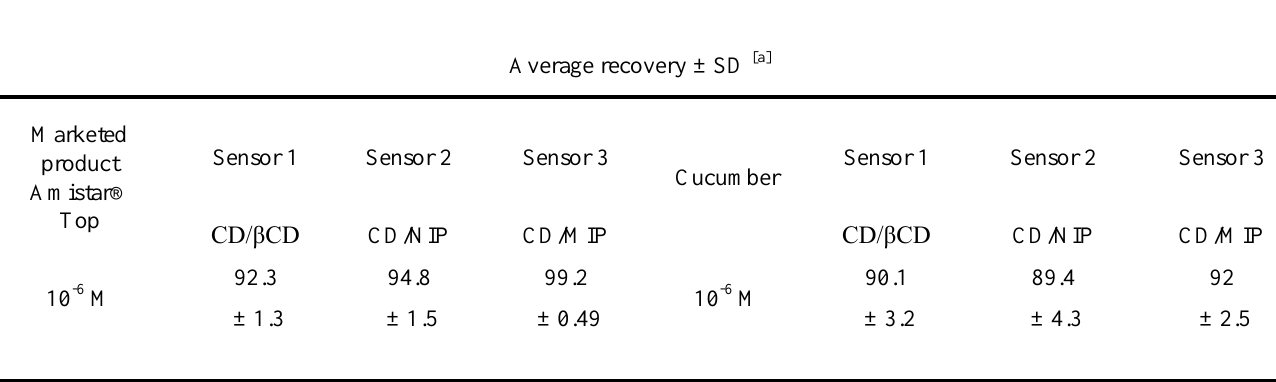
Table 3. Determination of azoxystrobin in marketed product